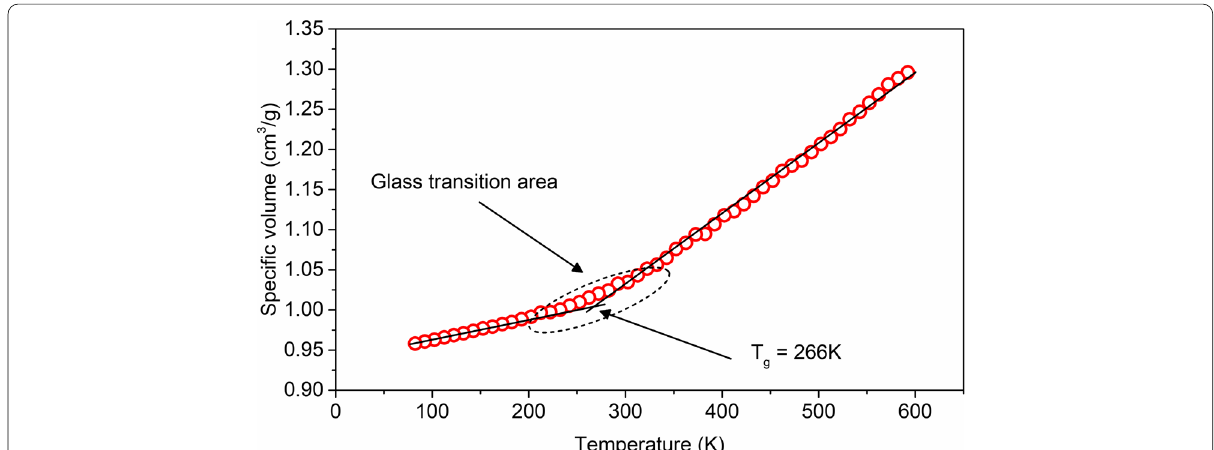
Fig. 10 Specific Volume versus Temperature Diagrams for Virgin Asphalt Model at the Temperatures from 80 to 600 K